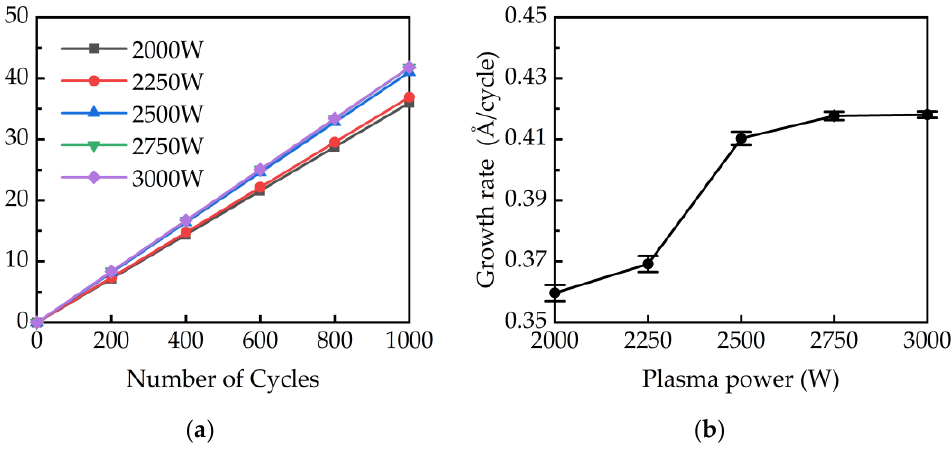
Figure 2. ( a ) The GaN thickness obtained after cycles at different plasma powers. ( b ) The growth rate of GaN calculated at different plasma powers.